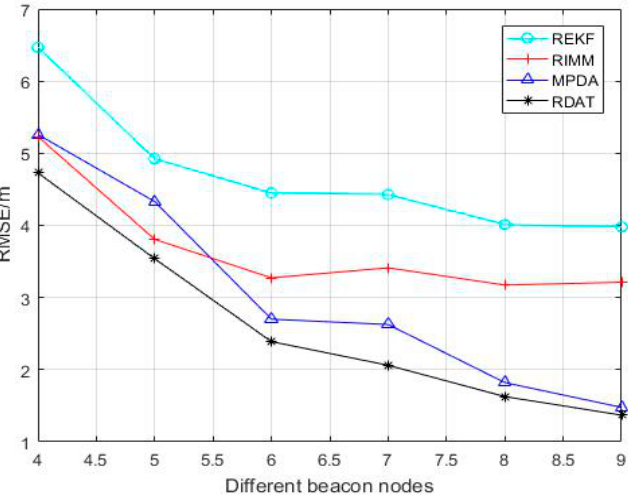
Figure 2. Performance comparison between the RIMM, robust extend Kalman filter (REKF), MPDA, and RDAT under di ff erent number of anchor nodes M , where P NLOS = 0.5, N